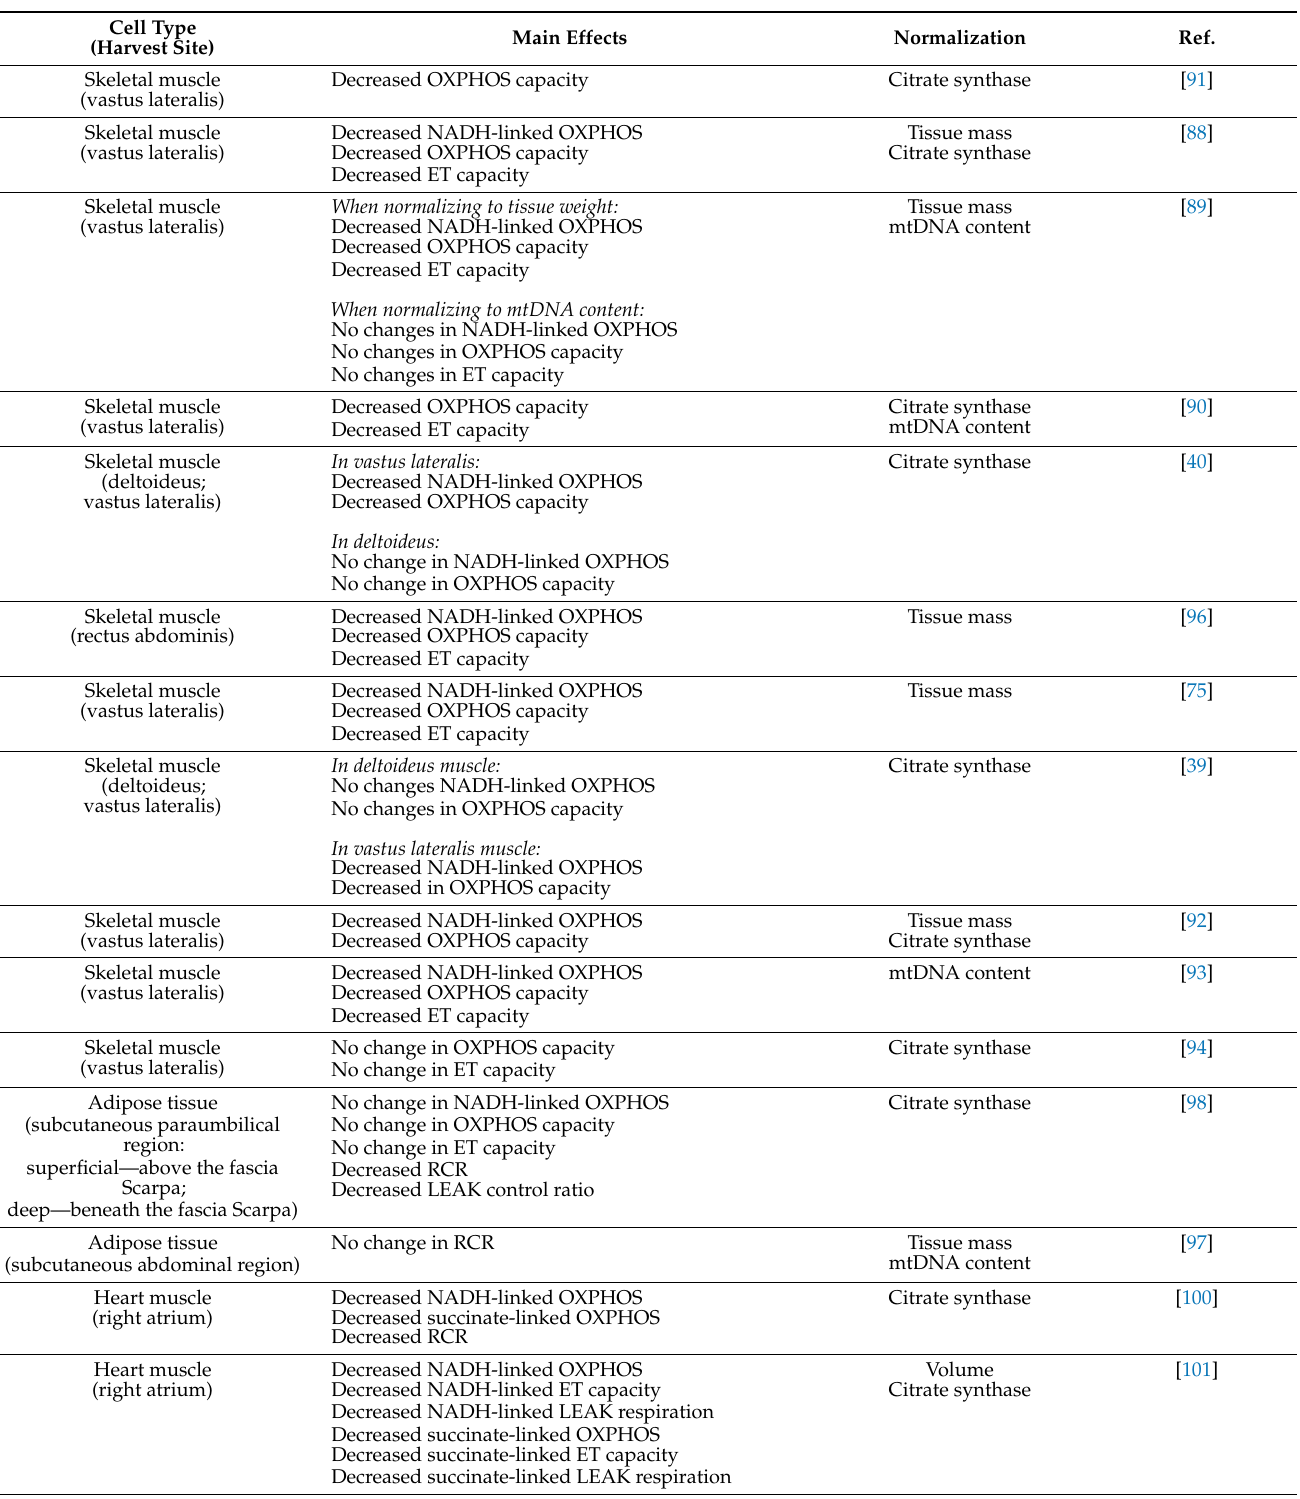
Table 6. High-resolution respirometry findings in human diabetes